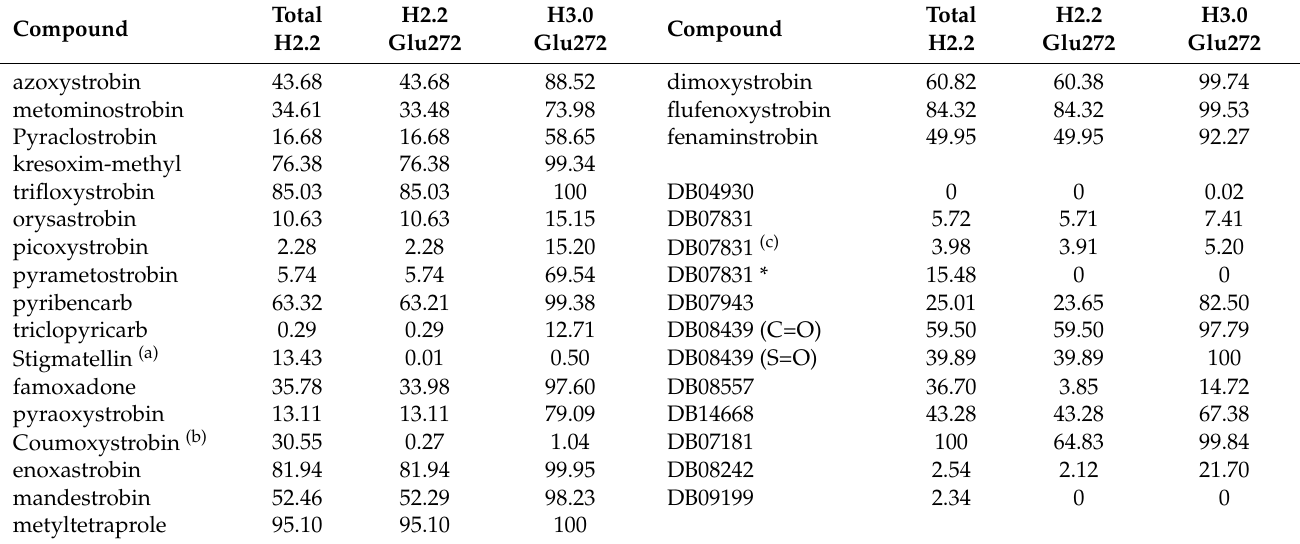
Table 2. Molecular dynamics result in an H-bond table. By default are shown compounds with SHB conformations (unless it is stated that it is about highest scored conformation (HSC). ‘Total H2.2’ represents the percentage of time H-bond (X...H–X < 3.2 Å, X...H < 2.2 Å) and is established in an MD trajectory, ‘H2.2 Glu272’ and ‘H3.0 Glu272’ are respectively defined as strong and weak H-bonds (X...H–X < 3.2 Å, X...H < 2.2 Å and X...H–X < 4,0 Å, X...H < 3.0 Å) between ligand atoms (O,N,Cl,F) and H-N of